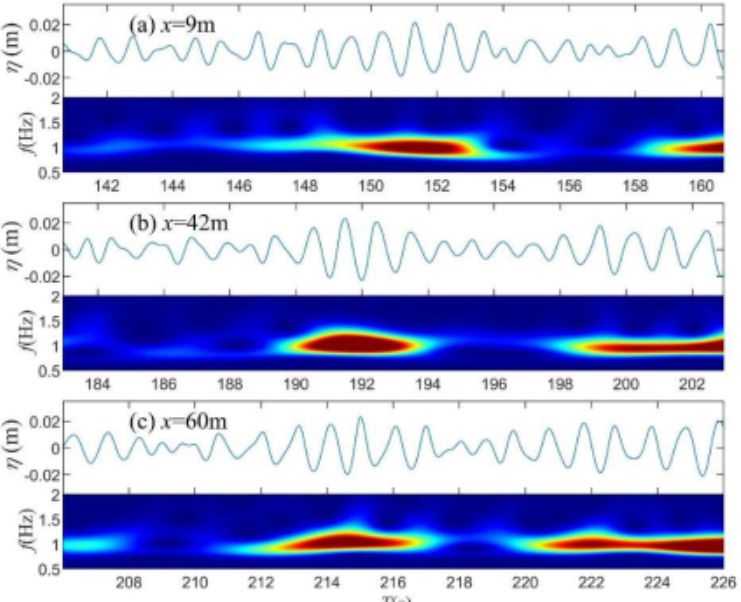
Figure 13. The time series and corresponding wavelet spectrum for Soliton 2 at three